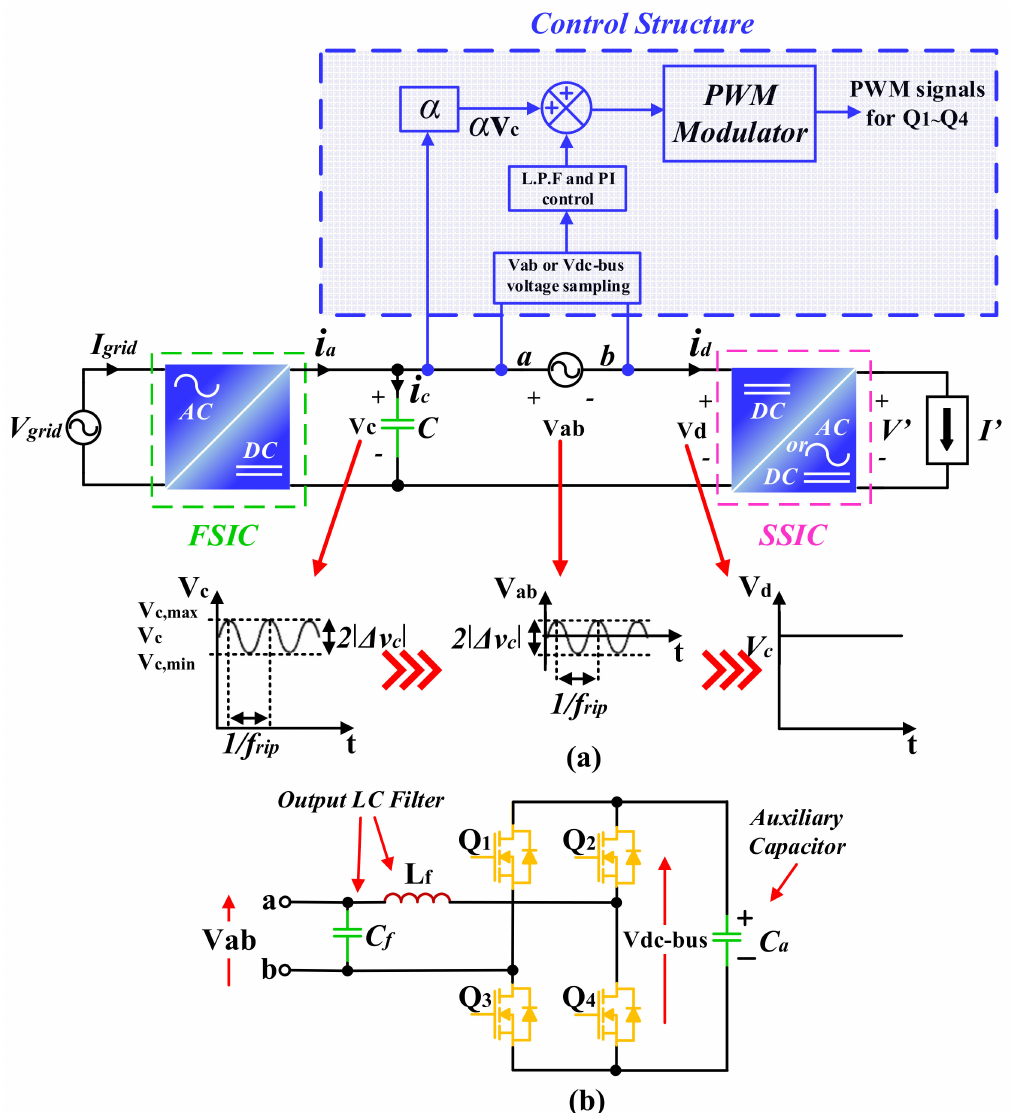
Figure 11. ( a ) Basic concept of implementing a voltage compensator circuit for typical energy conversion system; ( b ) Voltage compensator